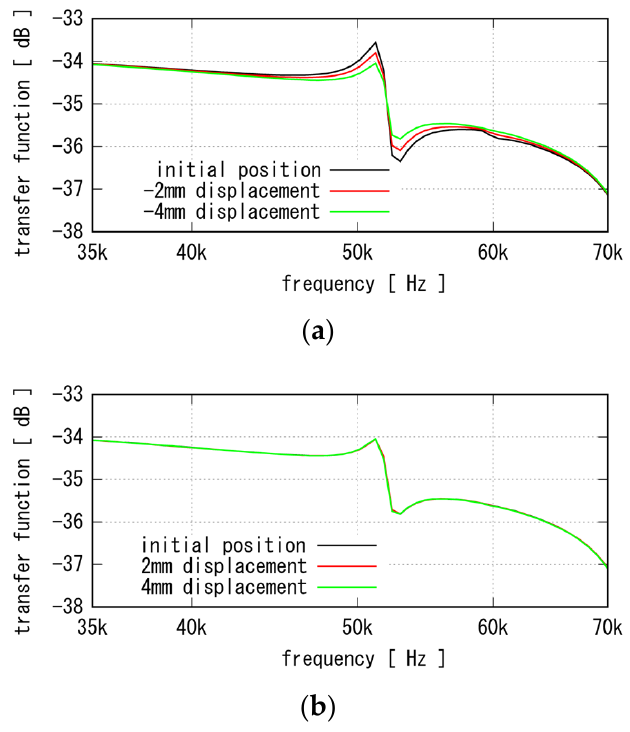
Figure 4. Example of amplitude variation of RBS due to ( a ) axial [28] and ( b ) horizontal displacement of HV winding. (The signs ‘-’ in the legend in ( a ) indicate downward AD.).